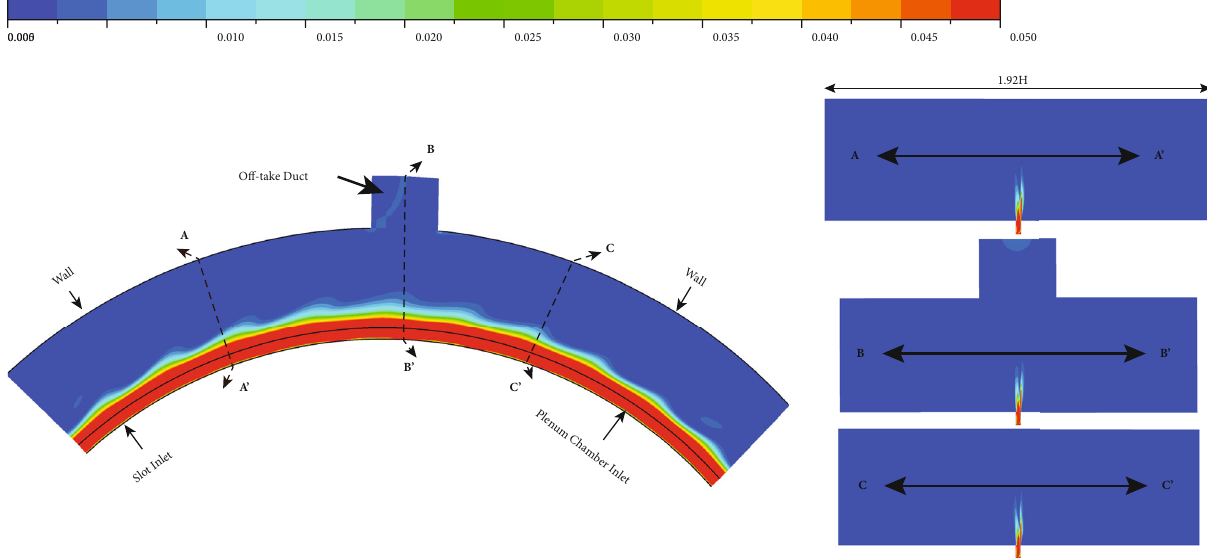
Figure 17: Normalized entropy generation rate of bleed system for plenum chamber with a radial height of 0.62 H and an axial width of 1.92 H